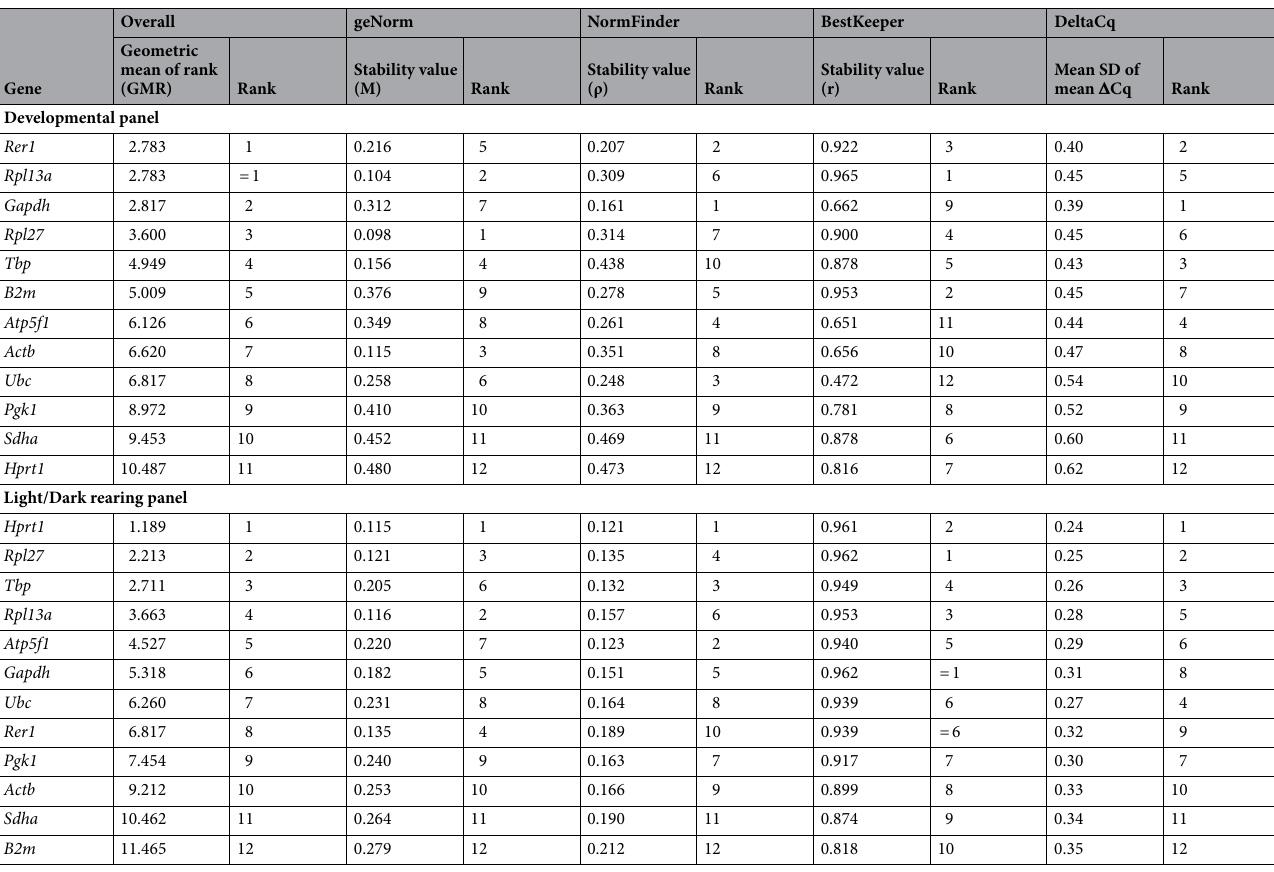
Table 3. Stability values and rankings of ChP from the Development and the Light/Dark rearing panels calculated by four algorithms: geNorm, NormFinder, BestKeeper, DeltaCq and the overall ranking. Gene’s stability decreases from 1 st to 12 th